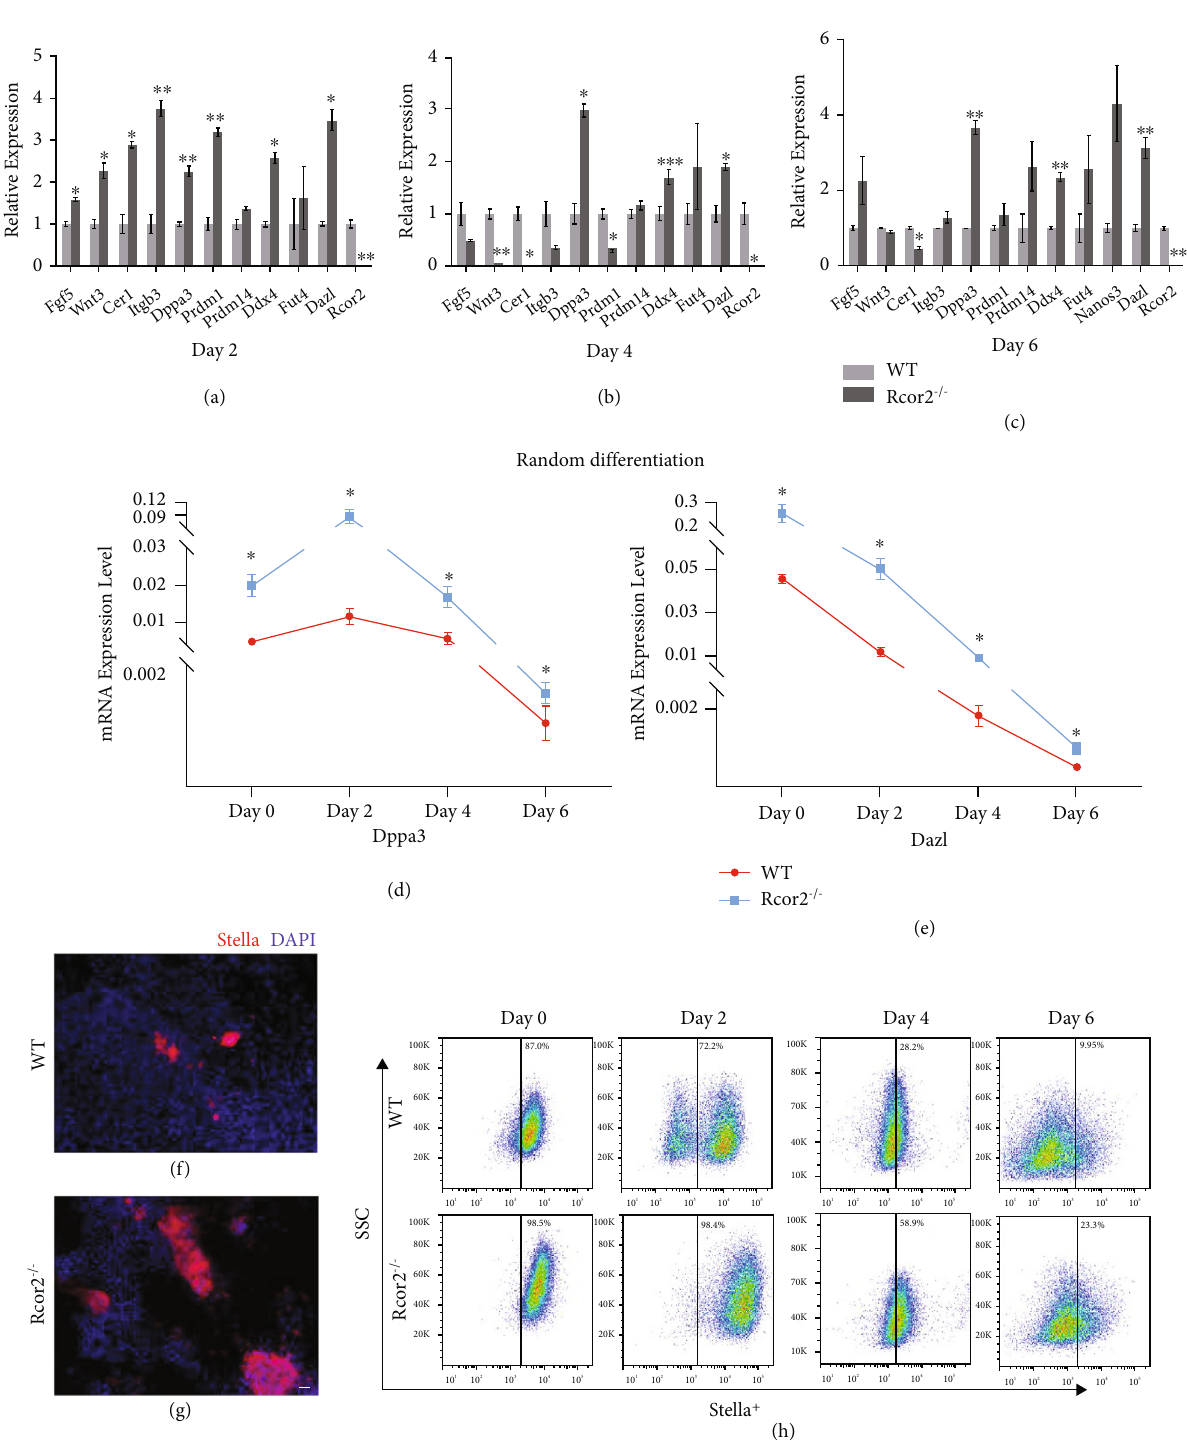
Figure 4: Rcor2 knockout promotes PGC di ff erentiation. (a – c) Relative expression of PGC marker genes in WT and Rcor2 -/- mESC-derived cells at day 2 (a), day 4 (b), and day 6 (c) of spontaneous random di ff erentiation. (d, e) mRNA expression level of Dppa3 (d) and Dazl (e) during spontaneous random di ff erentiation at day 0, day 2, day 4, and day 6. (f, g) Immuno fl uorescence staining for DAPI (blue) and Stella (red) in WT (f) and Rcor2 -/- (g) mESC-derived cells at day 9 of spontaneous random di ff erentiation. Scale bars, 100 μ m. (h) Flow cytometric analysis of Stella positive cell in WT and Rcor2 -/- mESC-derived cells during spontaneous random di ff erentiation at day 0, day 2, day 4, and day 6. Data are expressed as mean ± SEM , n = 3 , ∗ p < 0 : 05 , ∗∗ p < 0 : 01 , ∗∗∗ p < 0 : 001